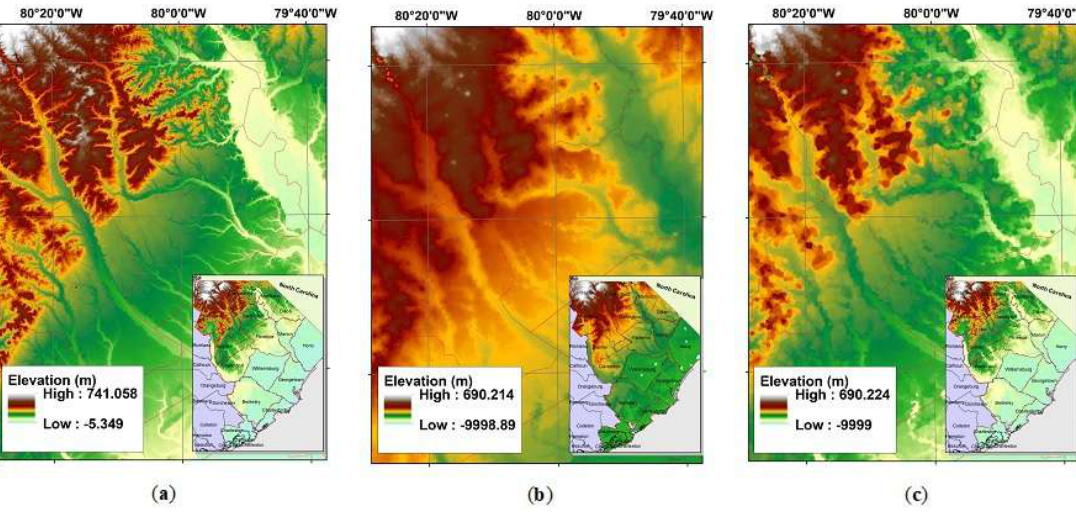
Figure 5. Comparison between digital elevation models (DEM) and interpolated imagery: ( a ) shows Light Detection and Ranging (LiDAR)-based DEM with 3 m × 3 m resolution, ( b ) shows IDW